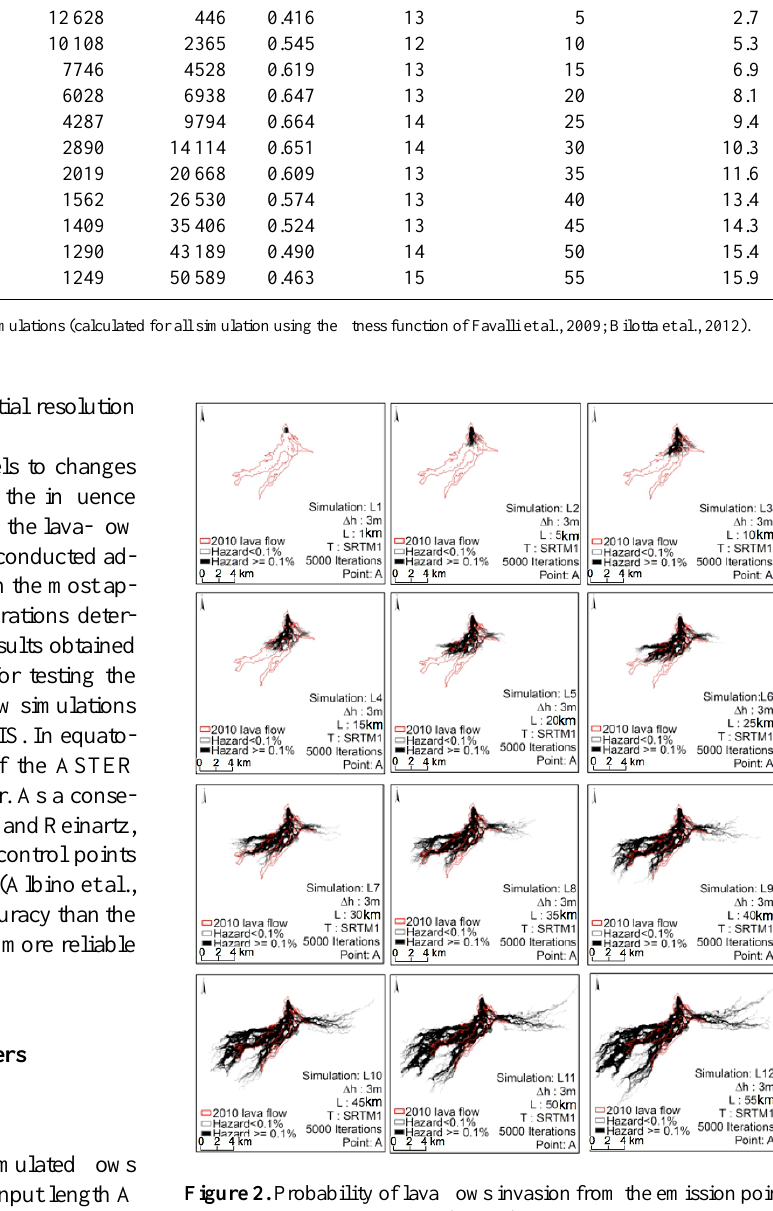
Table 1. Influence of the length parameter on the simulation of the 2010 lava flow of Nyamulagira. Simulation True lava Simulated Well Under- Outside Fitness Running Length Simulated lava flow pixels pixels estimated estimated true lava index* time parameter (km) flow longitudinal pixels pixels flow pixels (minutes) distance (km) L1